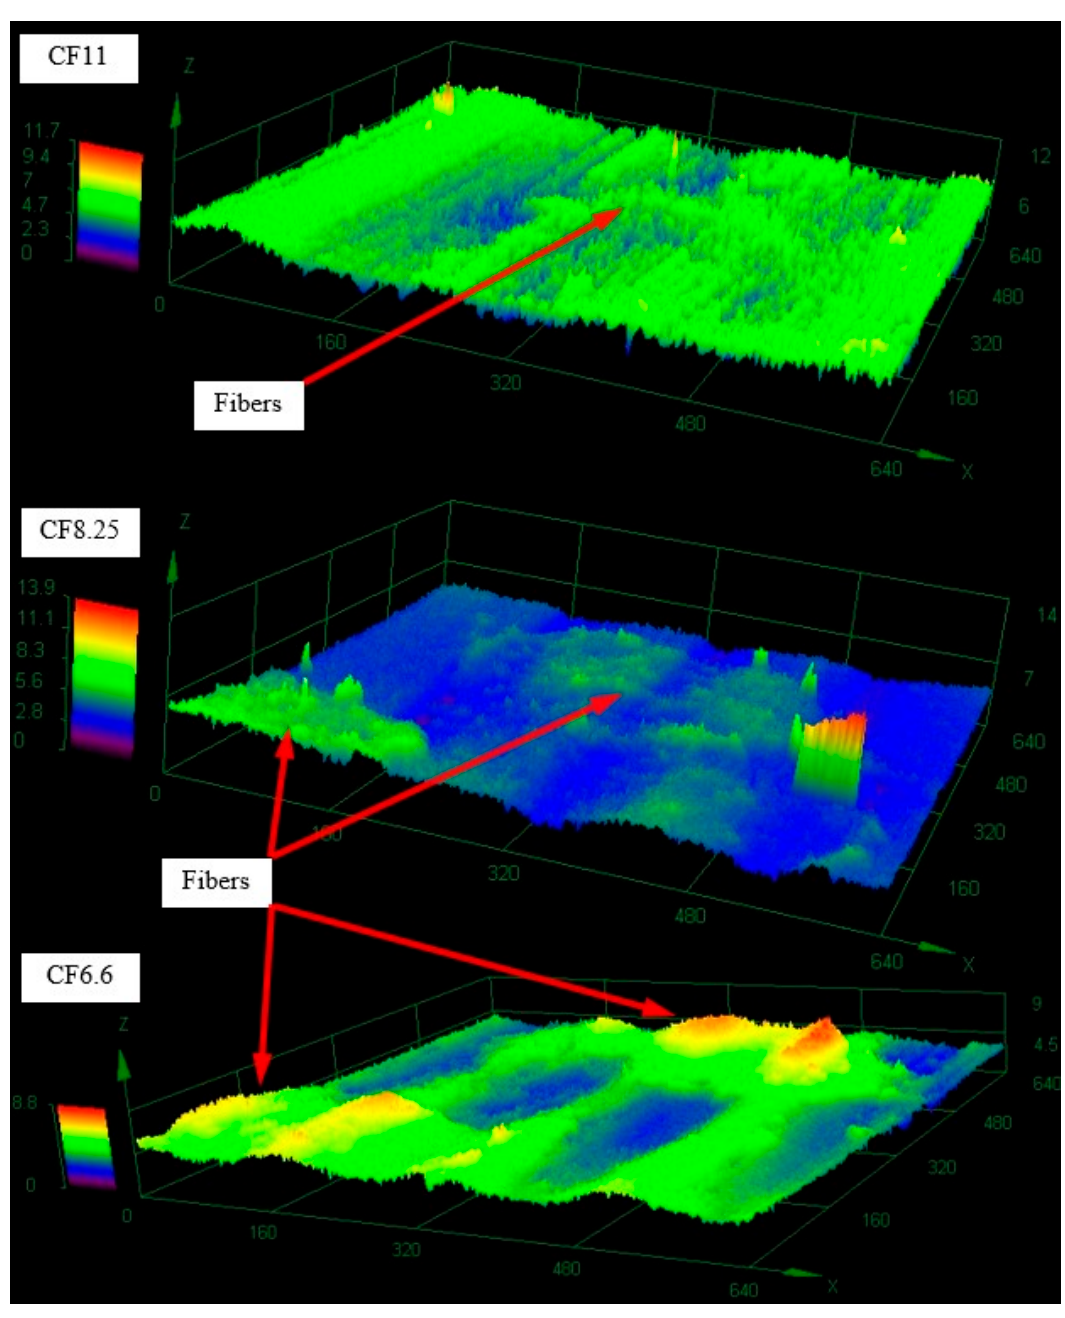
Figure 15. Topographies of ABS CF11; CF8.25; CF6.6 composites after tribological